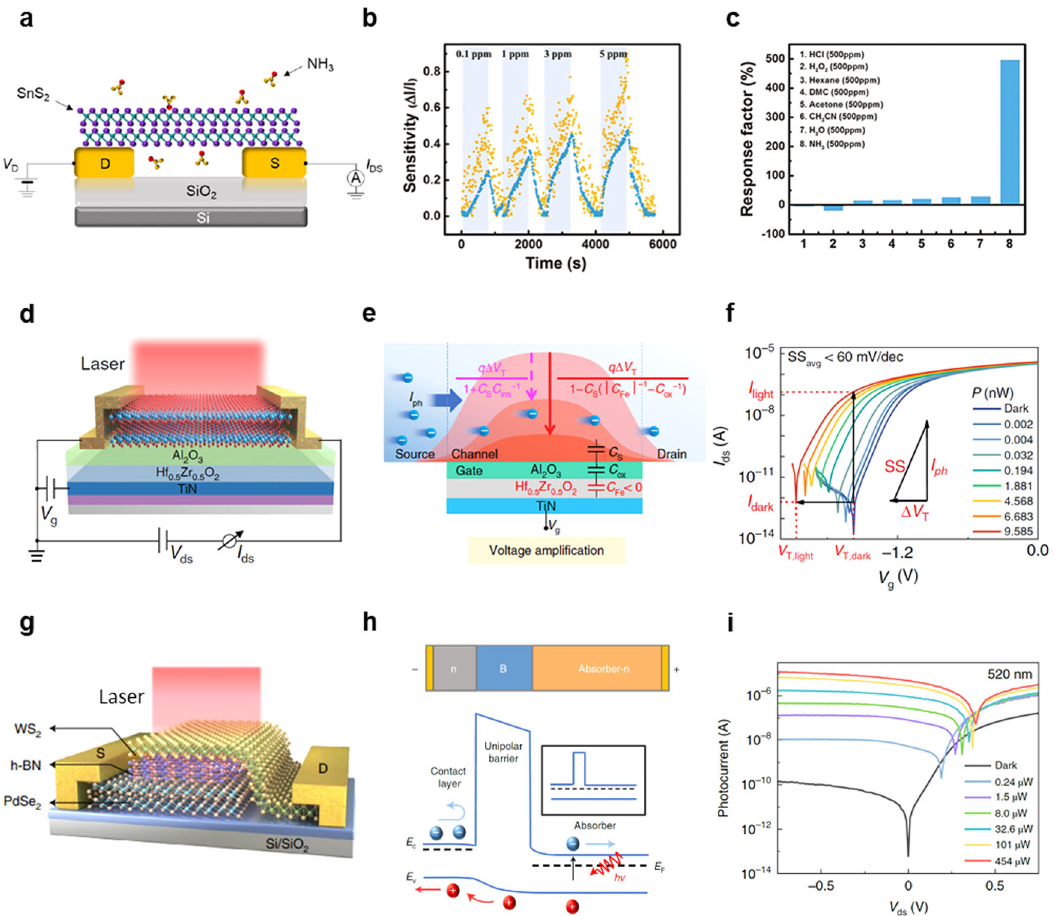
Fig. 8 2D semiconductors for sense. a Schematic of a suspended SnS 2 -based gas sensor. b Responses of the suspended SnS 2 -based sensor under different vapour conditions. c The selectivity of the suspended SnS 2 -based sensor in different gases and solvent vapours. a – c are reproduced from ref. 137 . d Schematic of a MoS 2 -based photoconductive mode detector with the ferroelectric HZO thin fi lm in the gate dielectric stack. e Mechanism of ultrasensitive optical detection in the negative-capacitance MoS 2 phototransistor. f Transfer curves of the NC MoS 2 phototransistor under different light. d – f are reproduced from ref. 139 . g Schematic of vdW unipolar barrier phototransistors. h Band alignment of the vdW unipolar barrier phototransistors. i Output curves of the vdW unipolar barrier phototransistors under different light. g – i are reproduced from ref. 140